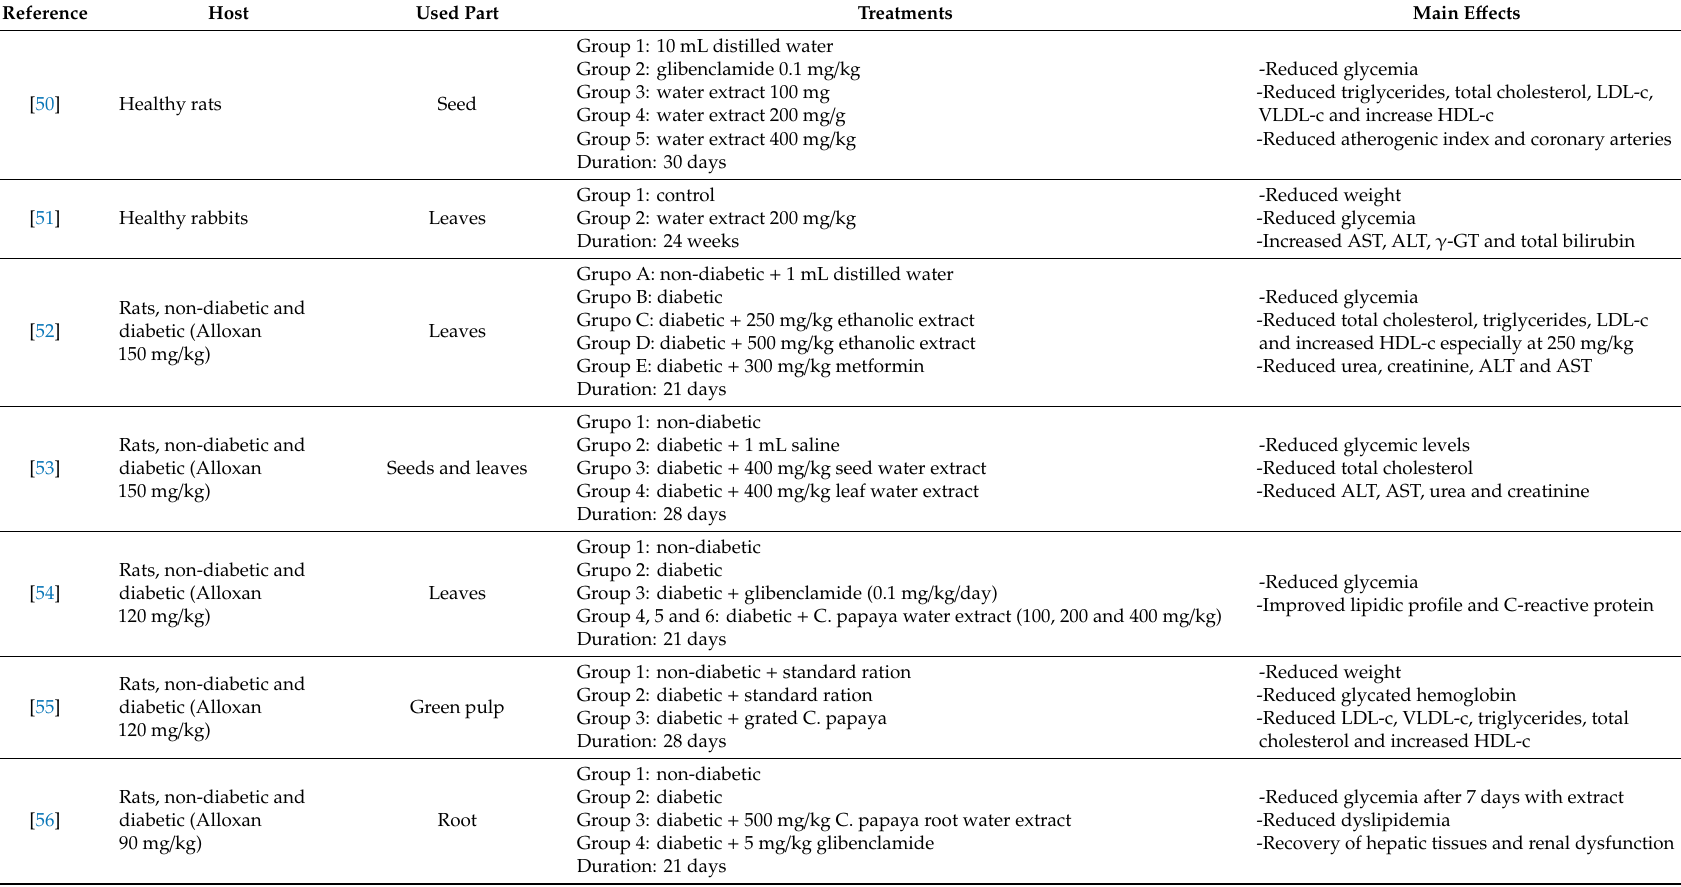
Table 4. Summary of e ff ects of the use of Carica papaya L. against metabolic